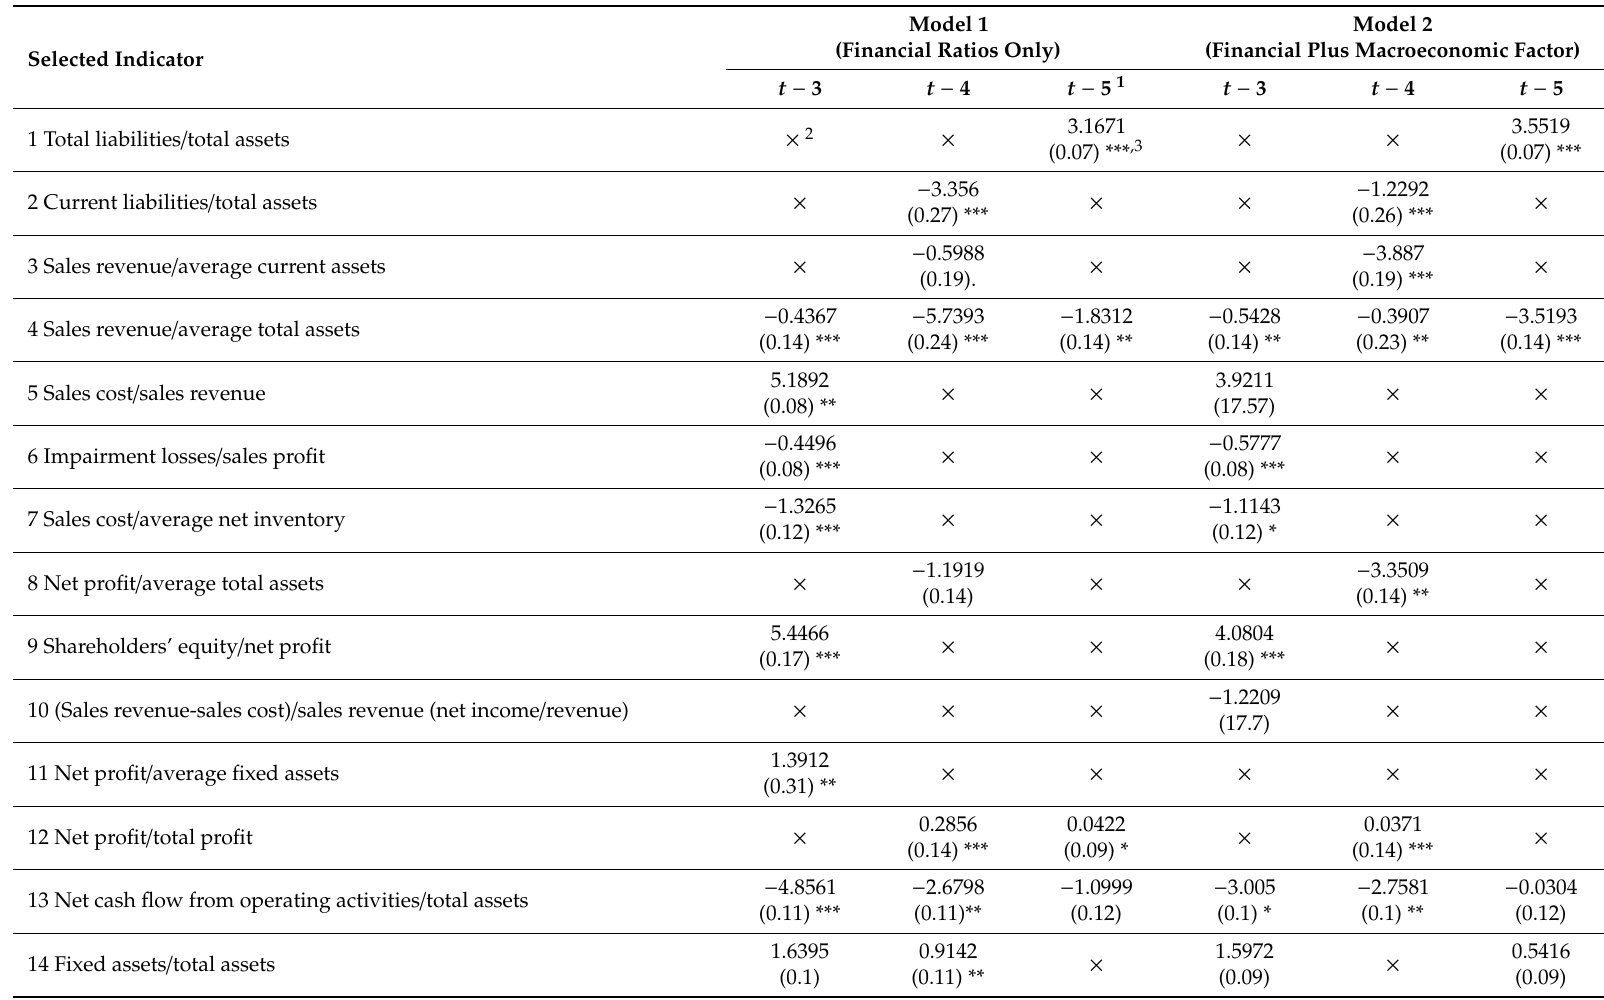
Table 3. The indicator selection and the estimates for lasso–logistic-distributed lag